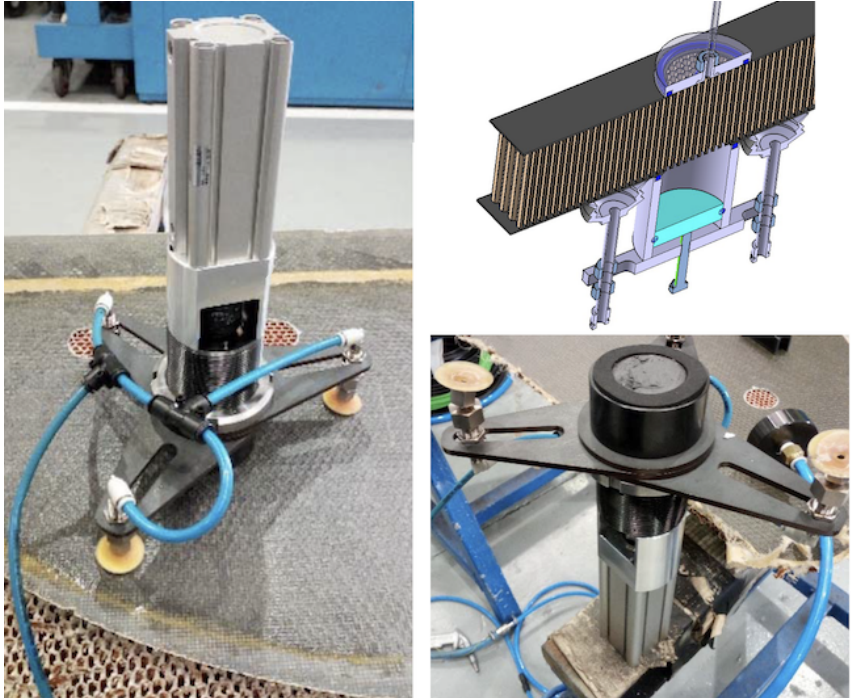
Figure 8. Vacuum-assisted multi-cell injector prototype. LEFT : The injection linear actuator and a resin chamber are located on top of the panel with three vacuum grips on an ad-hoc frame. RIGHT : The chamber-nozzle is a hollow cylinder filled with resin. The nozzle interface is a flat foam ring, mounted as a gasket. The vacuum nozzle used to assist the filling is located on the opposite side of the